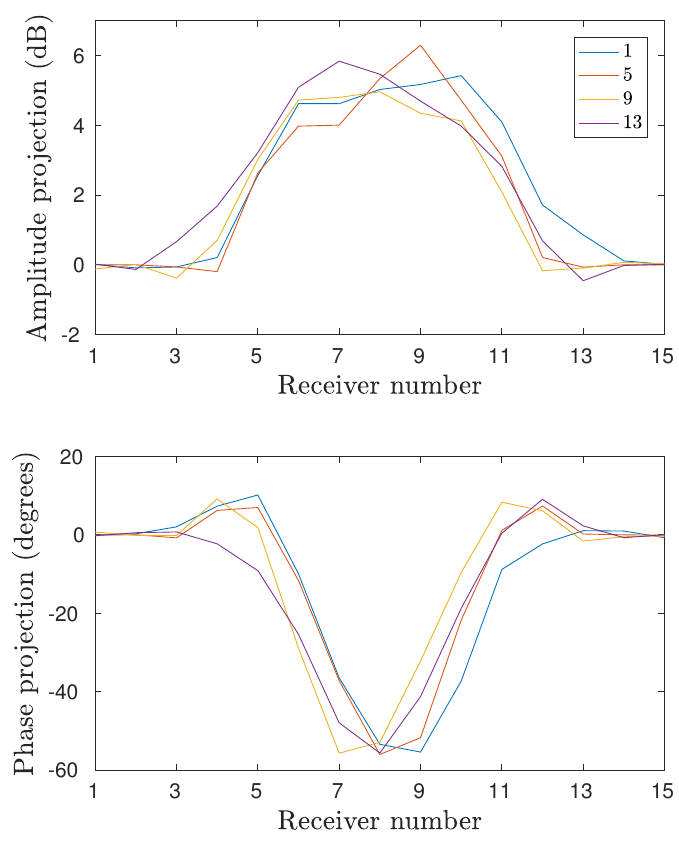
Figure 6. Projection data for four different transmitters: Antennas 1, 5, 9, and 13. Data are acquired at fourth layer and the inner shell is filled with the surrounding 80:20 glycerin–water